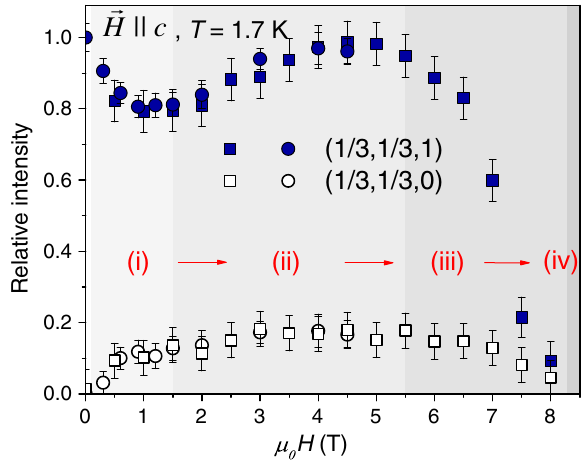
; 1 ; 0 Þ and ð 1 ; 1 ; 1 Þ peak 3 3 3 3 ⃗ H k c exposing the presence of at